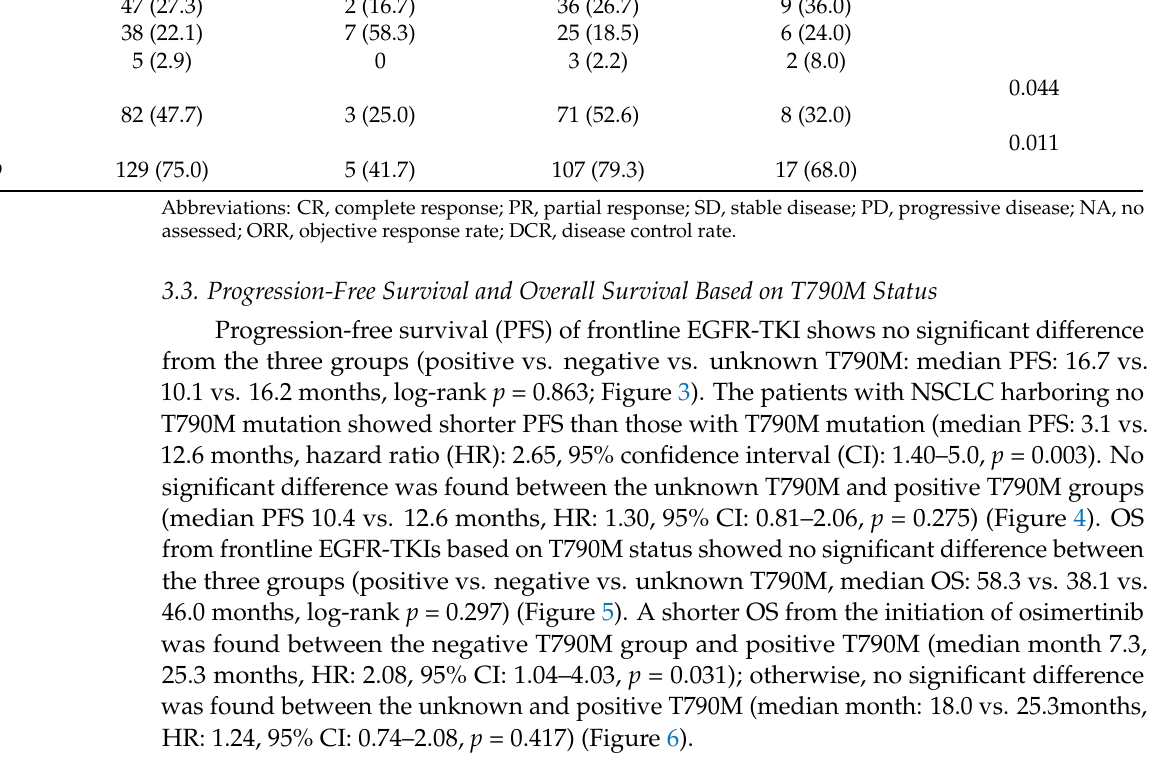
Figure 4. Progression-free survival of osimertinib based on T790M status.